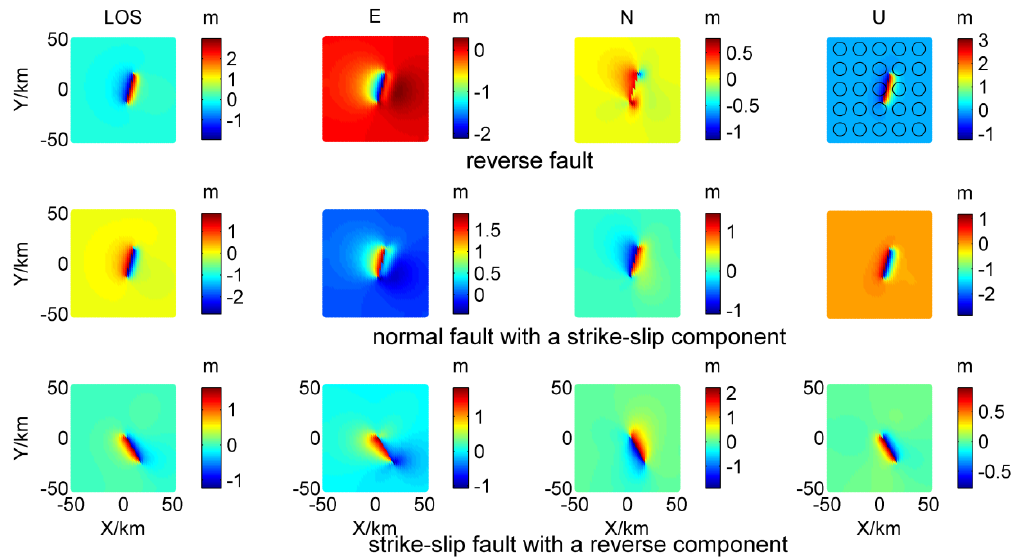
Figure 3. Simulated line of sight (LOS) displacement field and 3D displacement field for three types of faults. (The first line is a reverse fault. The second one is a normal fault with a strike-slip component. The last one is a strike-slip fault with a reverse